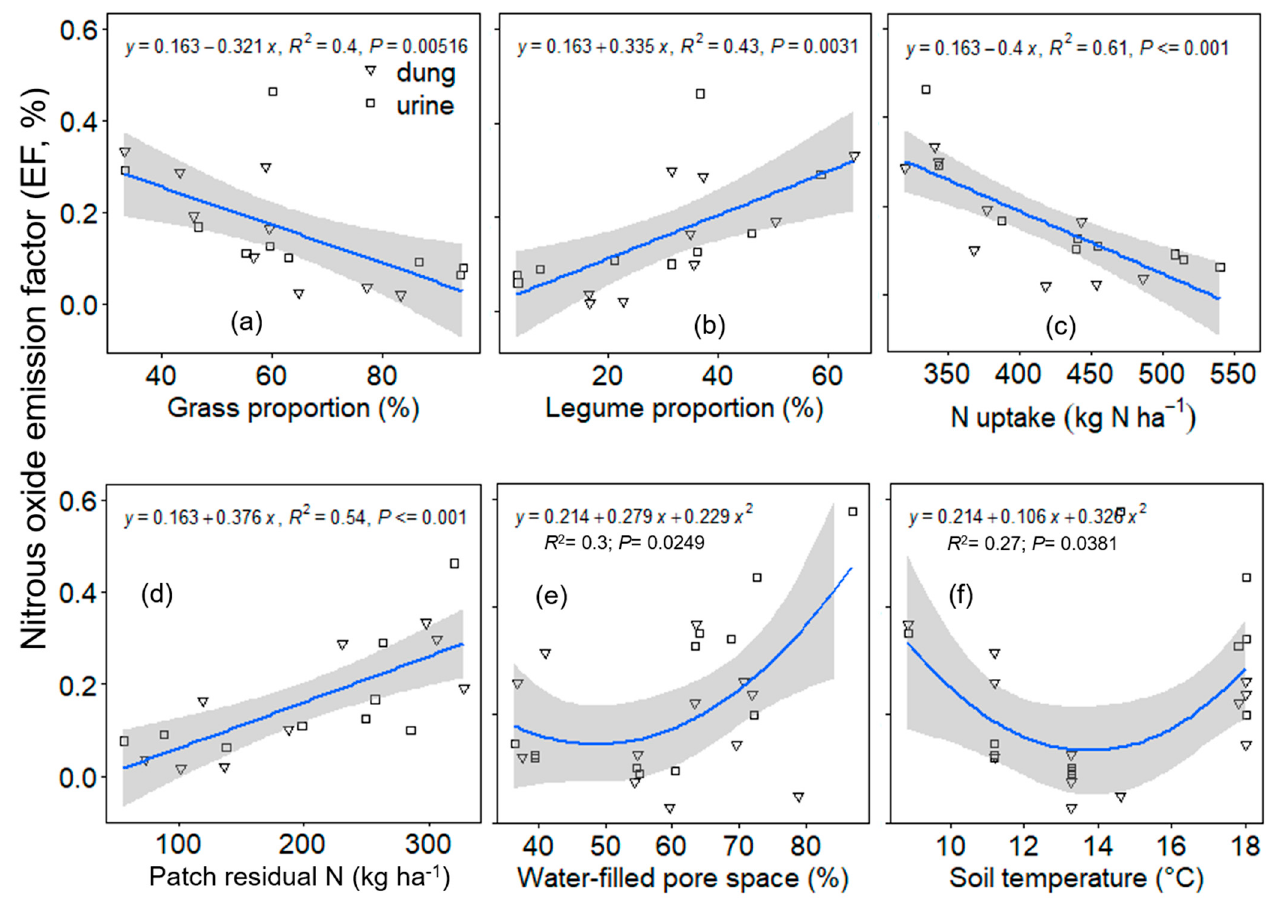
Figure 7. Graphs showing stoichiometric relationships between N 2 O-N EF from pastures and ( a ) grass or ( b ) legume proportion, ( c ) N uptake, ( d ) PRN, ( e ) water-filled pore space, and ( f ) soil temperature. The grey region is a 95% confidence interval. ( a – d ) Pooled across grasslands; ( e , f ) pooled across experiments 2 and 3. Individual dots indicate replicates of dung and urine patches.